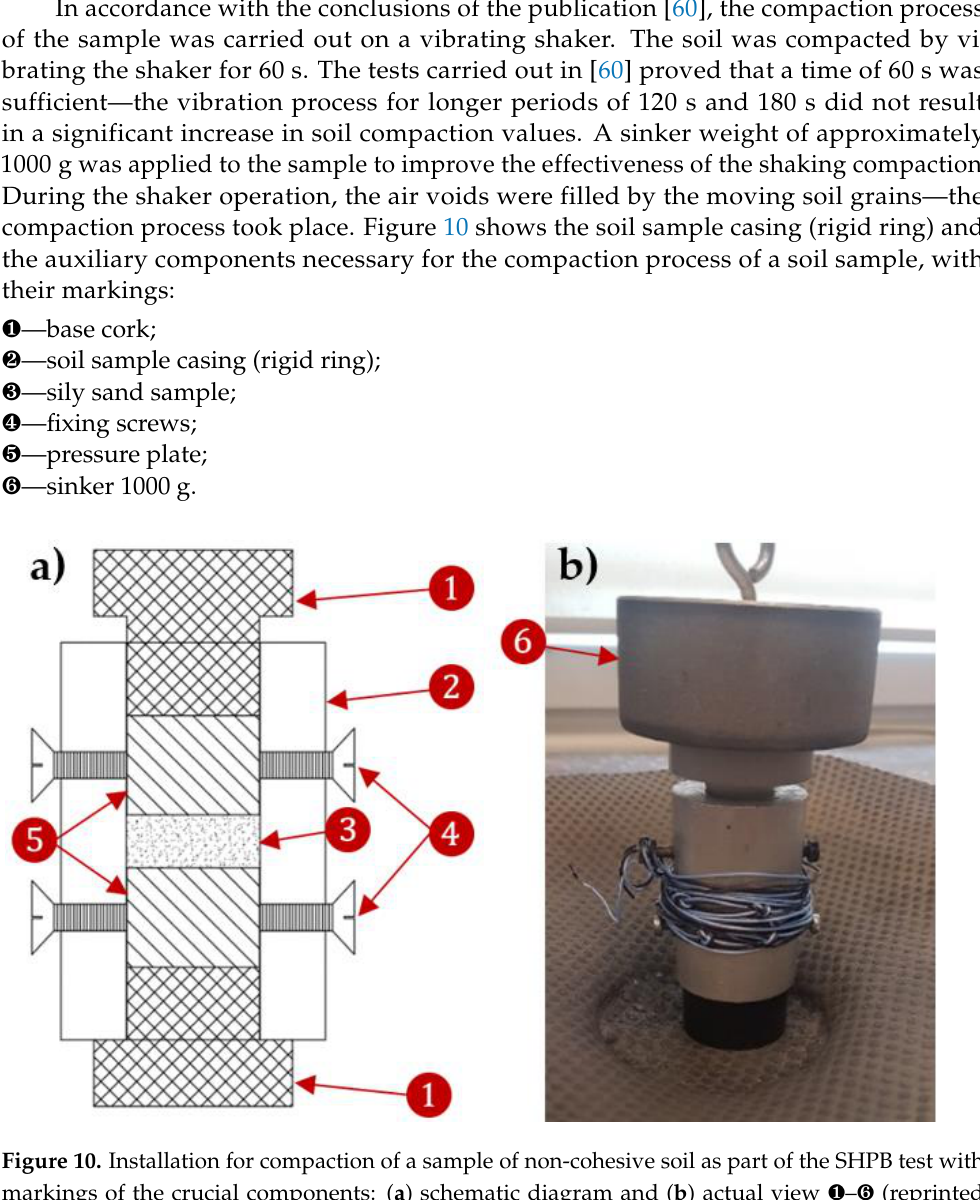
Table 3. Summary of silty sand sample variants used in experiments conducted on the SHPB test stand.